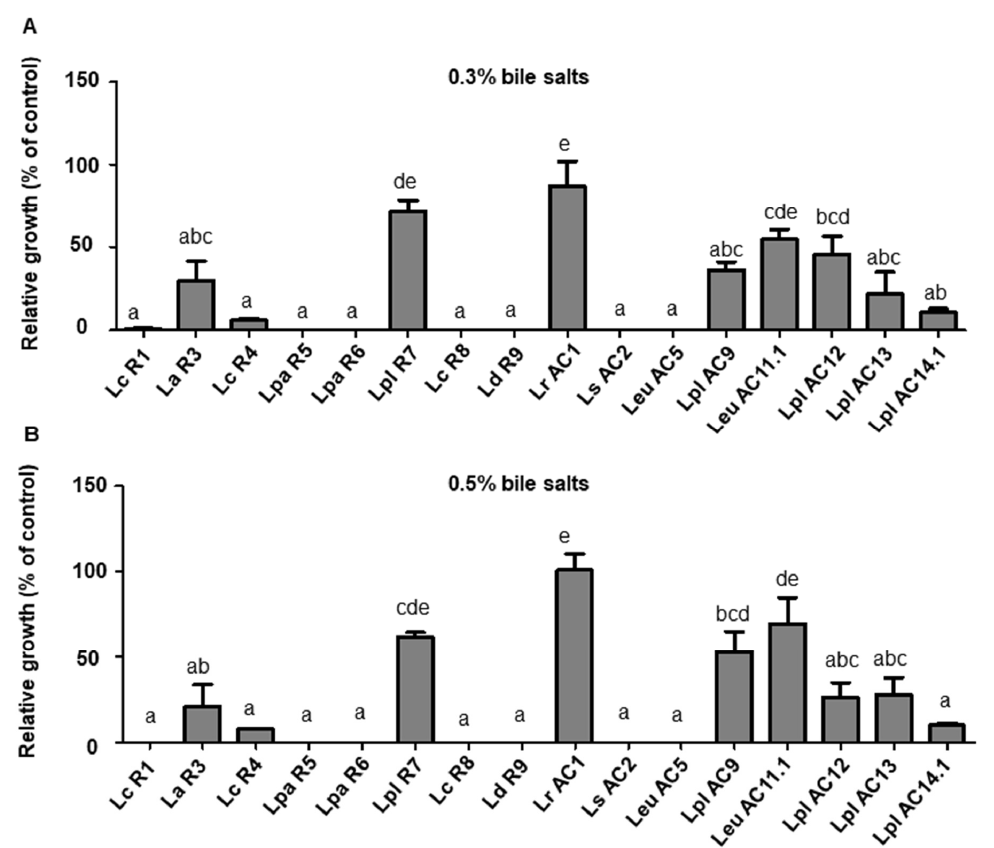
Figure 3. Relative growth of selected LAB isolates in the MRS plates supplemented with 0.3% ( A ) and 0.5% ( B ) bile salt after 24 h of incubation. Relative growth was determined by the colony-forming unit (CFU) of LAB grown in the MRS agars supplemented with different concentrations of bile salts to that in the regular MRS agar. Graph bars marked with different letters on top represent statistically significant results. The results were compared by one-way ANOVA and Turkey post hoc test; p < 0.05; n = 2. Lc, L. casei; La , L. acidophilus; Lpa , L. paracasei; Lpl , L. plantarum; Ld , L. delbrueckii; Lr , L. rhamnosus; Ls , L. sakei; Leu , Leu. mesenteroides.